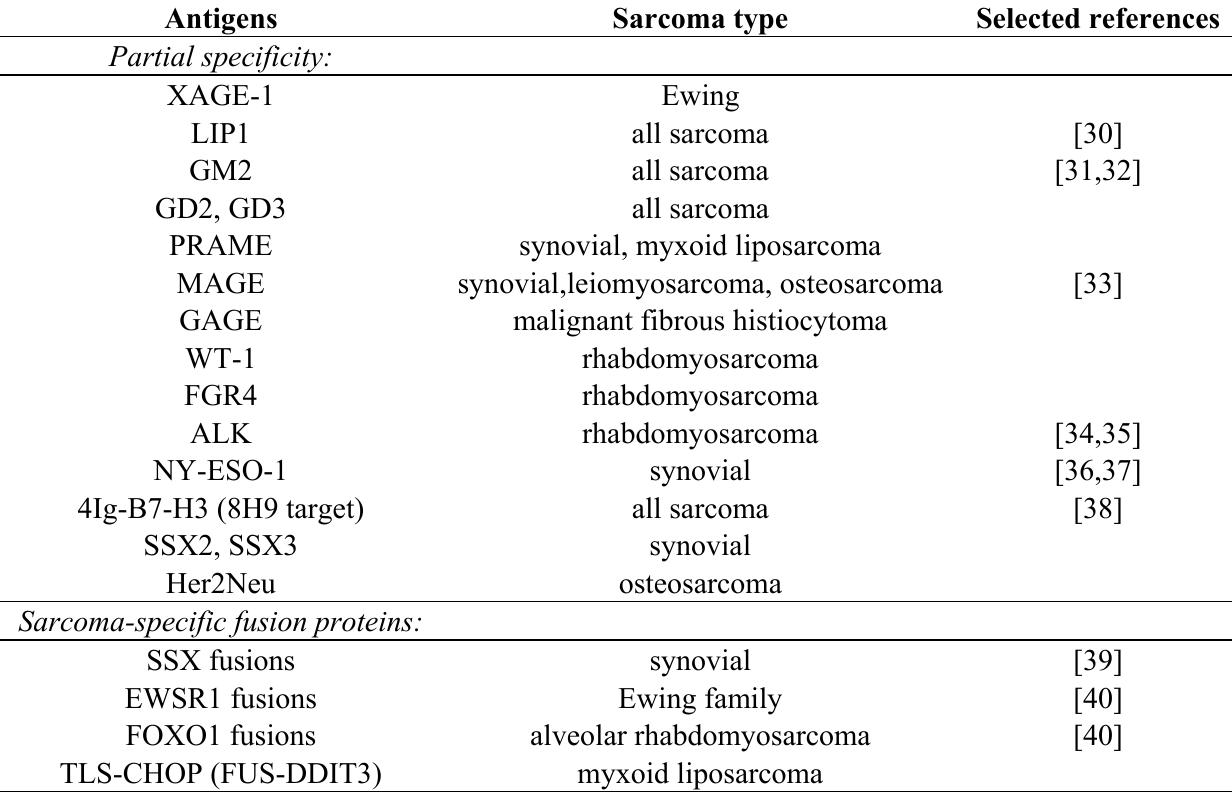
Table 1. Antigen epitopes with potential utility in sarcoma immunotherapy. Unless otherwise specified, references are described in [29]. It should be noted that some of the proposed epitopes are based on wide ranging of preclinical